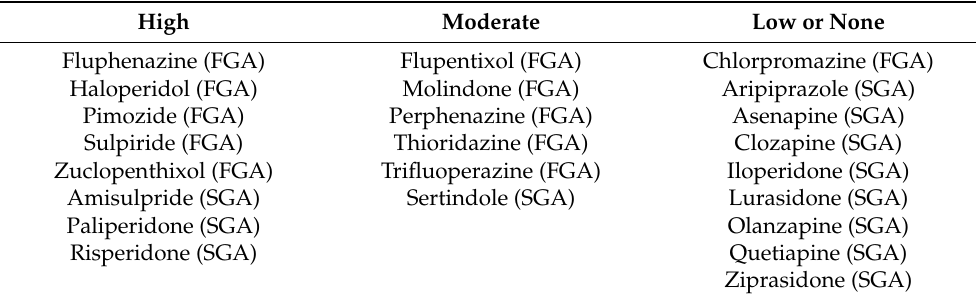
Table 2. The risk of inducing hyperprolactinemia by selected first- and second-generation antipsy- chotics based on